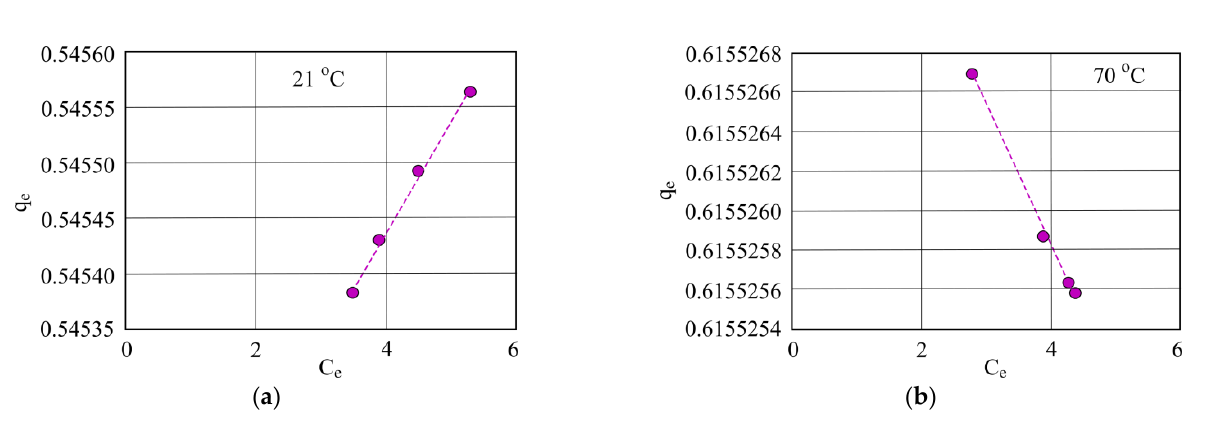
Figure 13. Freundlich isotherm when investigated water is at ( a ) 21 °C and ( b ) 70 °C using granu- lated mineral sorbent.